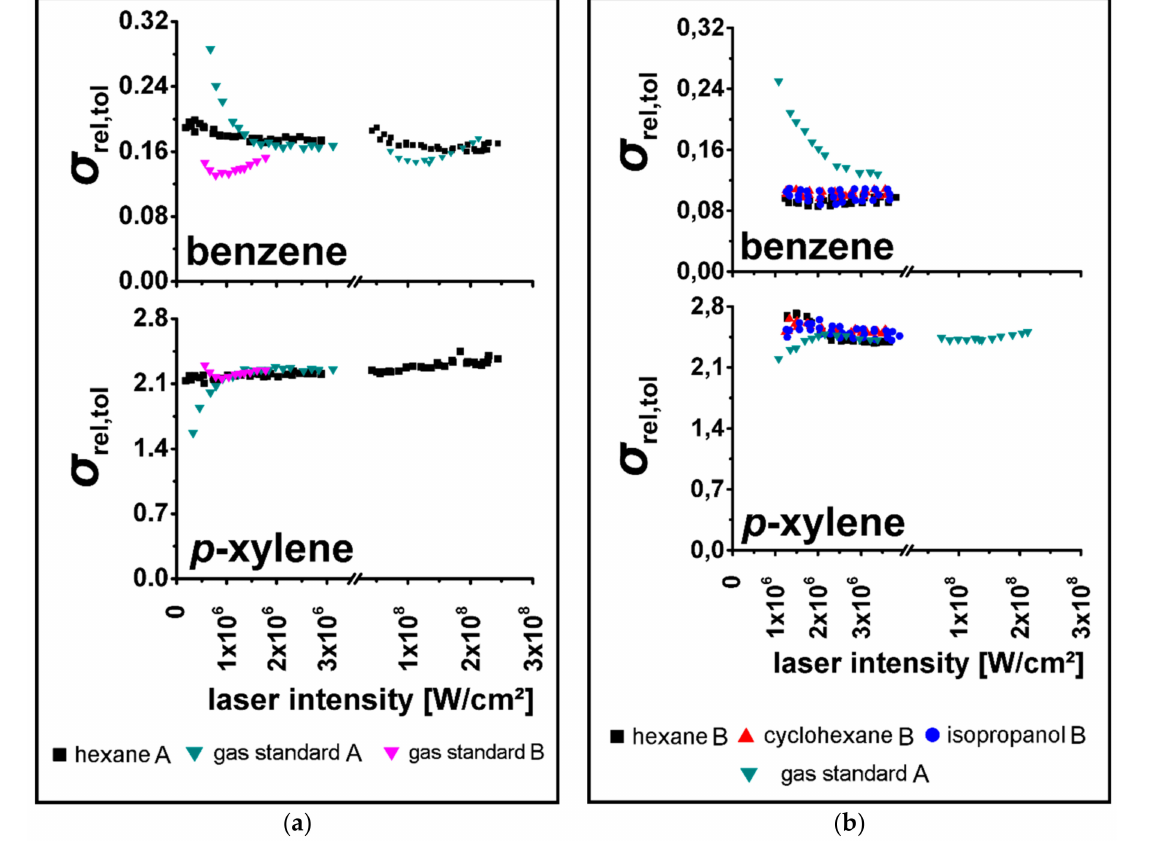
Figure 6. Relative REMPI cross sections ( σ rel,tol ; toluene was used as a reference substance) at 266 nm for benzene and p -xylene of different datasets: ( a ) dataset A; ( b ) dataset B (for benzene, no data were available at high